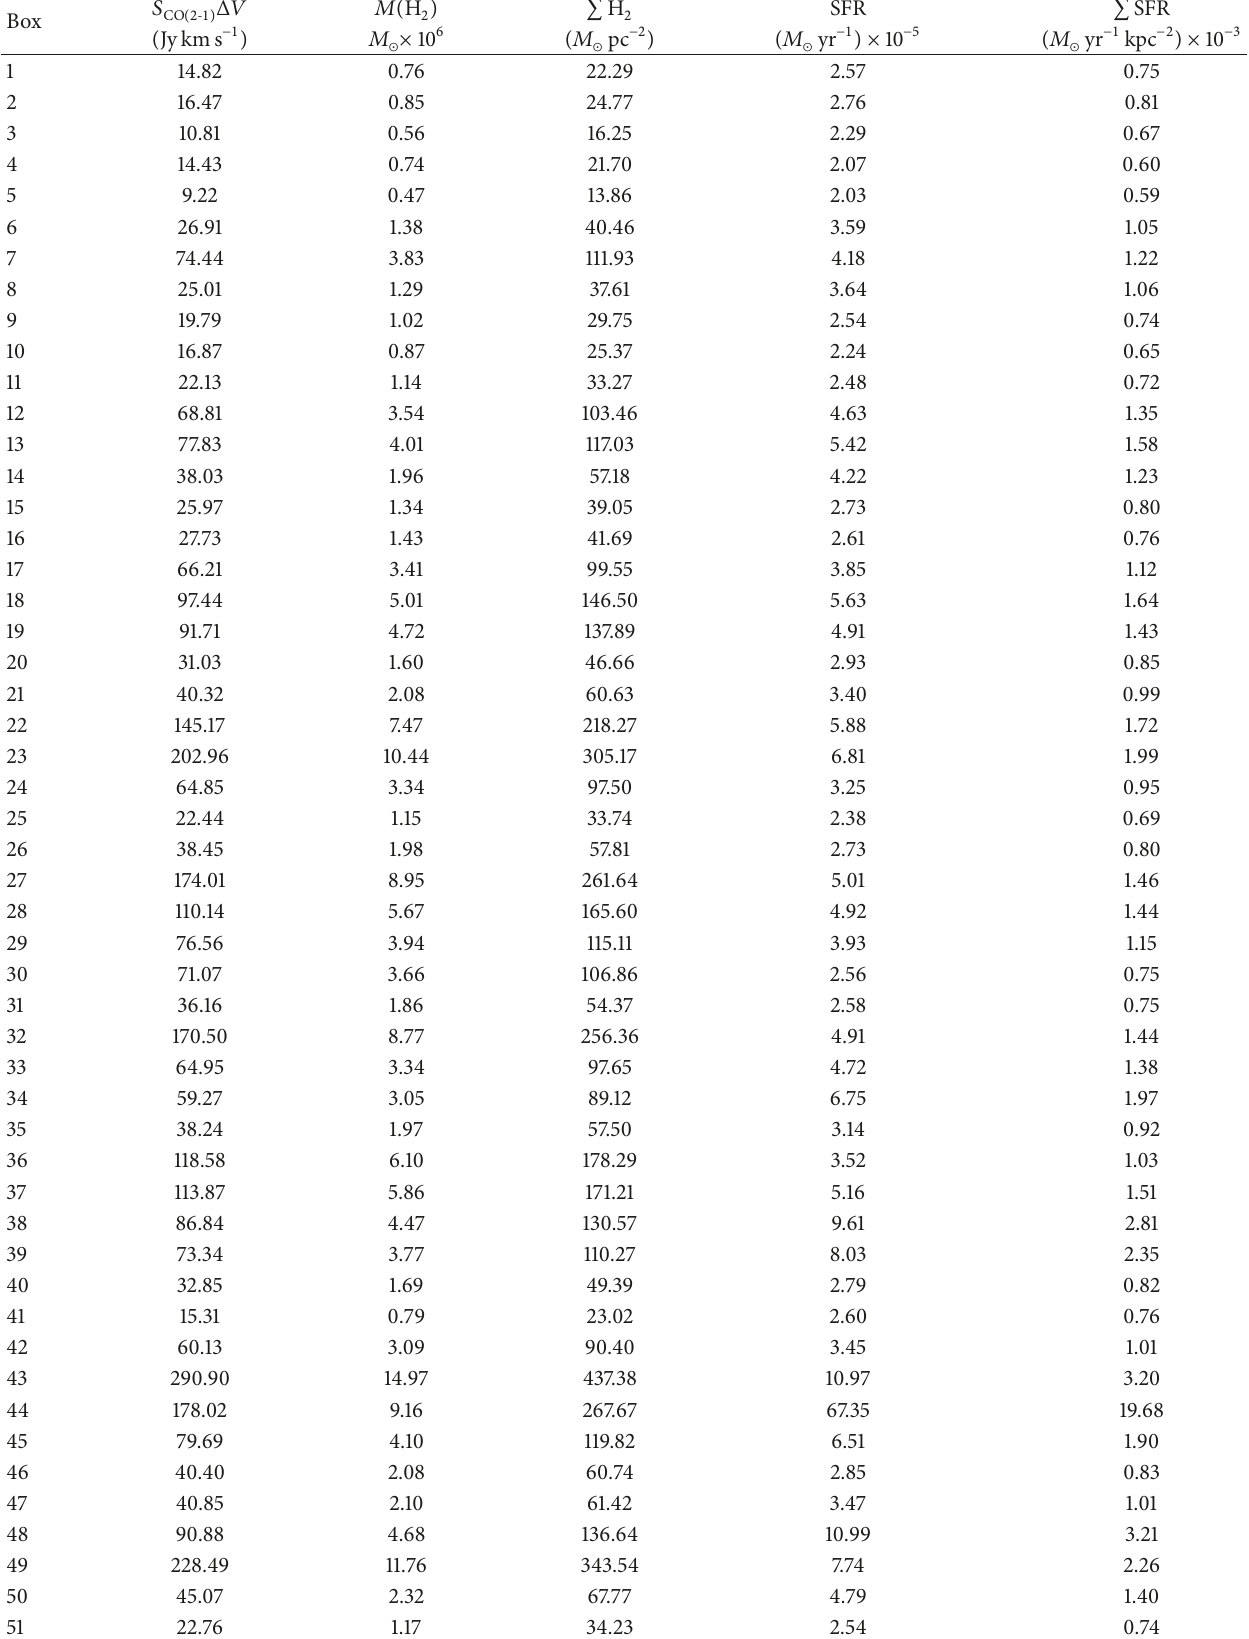
Table 2: CO intensity, molecular gas density and mass, star formation rate, and star formation rate surface density. With spatial resolution of 185 pc × 185